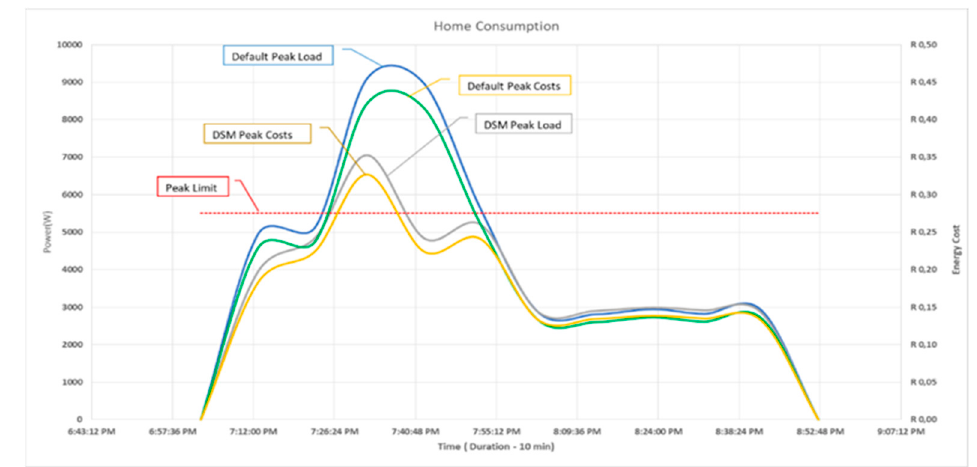
Figure 15. Peak load profiling via IoTivity HEM platform .